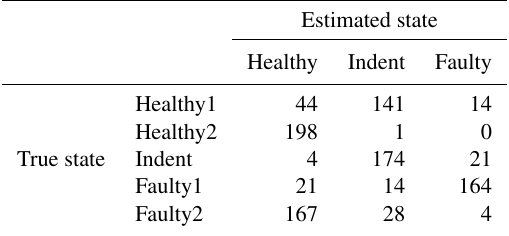
Table 12. Confusion matrix for 3000rpm MEMS data and the top four features, classifier trained with ramp-up data, with an addi- tional offset in the steady-state validation data.